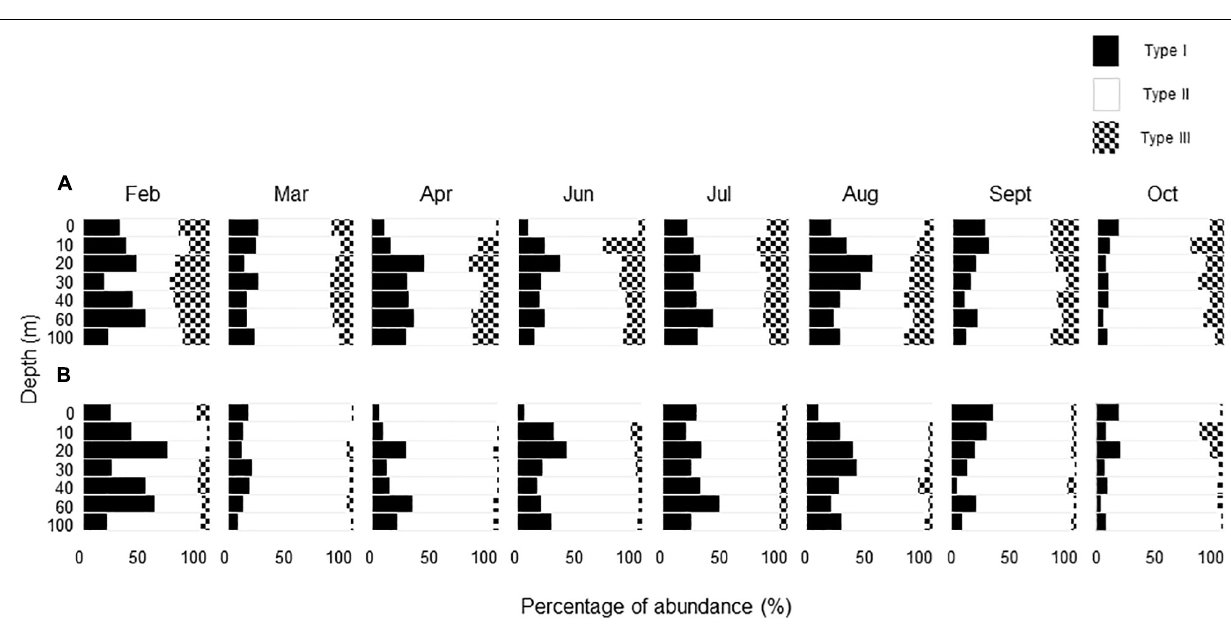
FIGURE 3 | Seasonal changes in vertical distribution of the percentage of each transparent exopolymer particle (TEP) type to the total TEP in terms of (A) number and (B)